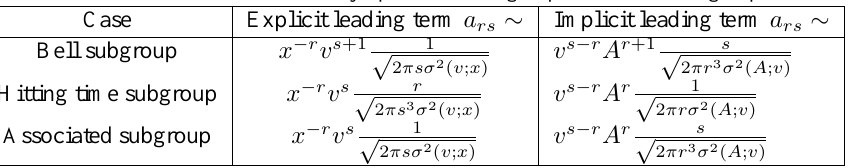
Tab. 2: Asymptotics for subgroups of the Riordan